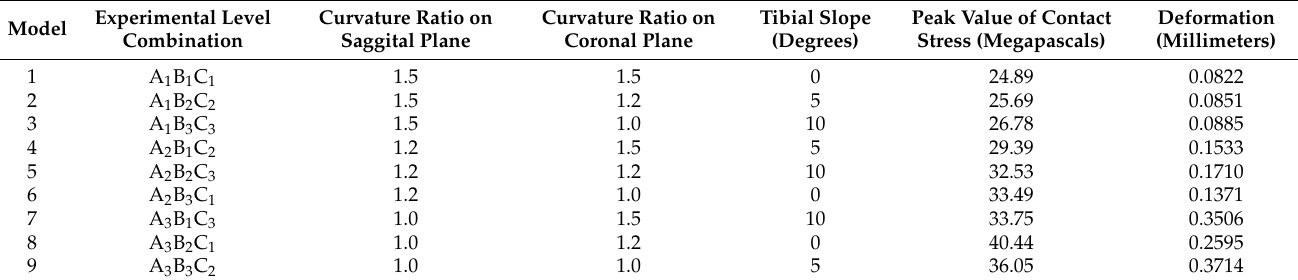
Figure 4. Deformation of the UHMWPE tibial insert. ( a ) Model of the A 1 B 1 C 1 group; ( b ) model of the A 1 B 2 C 2 group; ( c ) model of the A 1 B 3 C 3 group; ( d ) model of the A 2 B 1 C 2 group; ( e ) model of the A 2 B 2 C 3 group; ( f ) model of the A 2 B 3 C 1 group; ( g ) model of the A 3 B 1 C 3 group; ( h ) model of the A 3 B 2 C 1 group; ( i ) model of the A 3 B 3 C 2 group; and ( j ) model of the A 1 B 1 C 2 group (optimised). Table 4. Experimental level combinations of orthogonal experimental